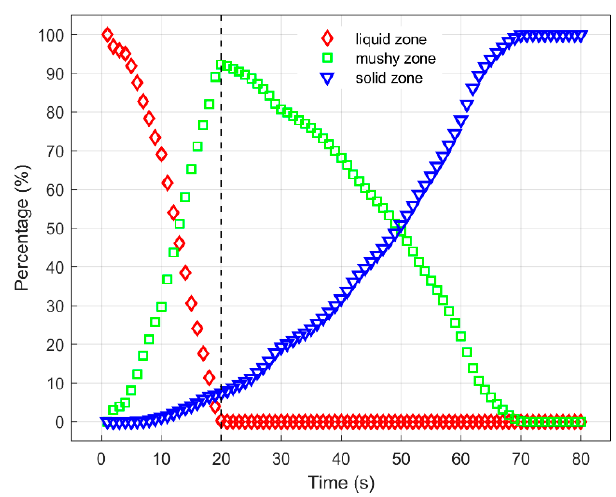
Figure 13. The curve of percentage by volume of three zones over time during solidification. The three curves were divided into two halves, with the 20 s time point as the dividing